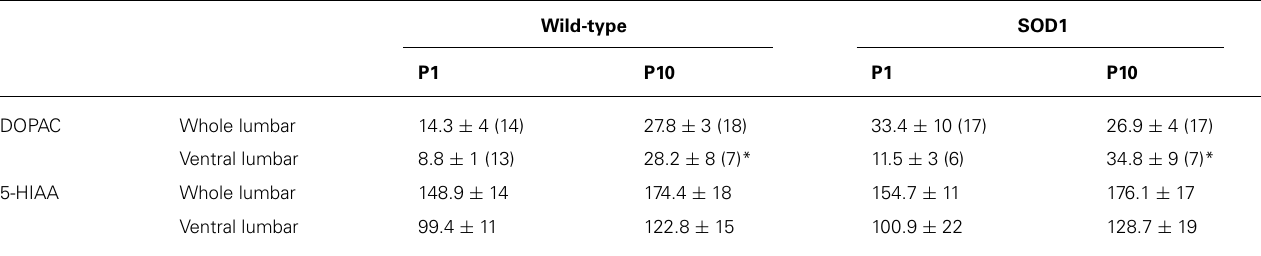
Table 1 | HPLC measurements of 3,4-dihydroxyphenylacetic acid (DOPAC) and 5-hydroxyindole-3-acetic (5-HIAA) contents in the whole or ventral part of the lumbar spinal cord from P1 and P10WT and SOD1 mice.